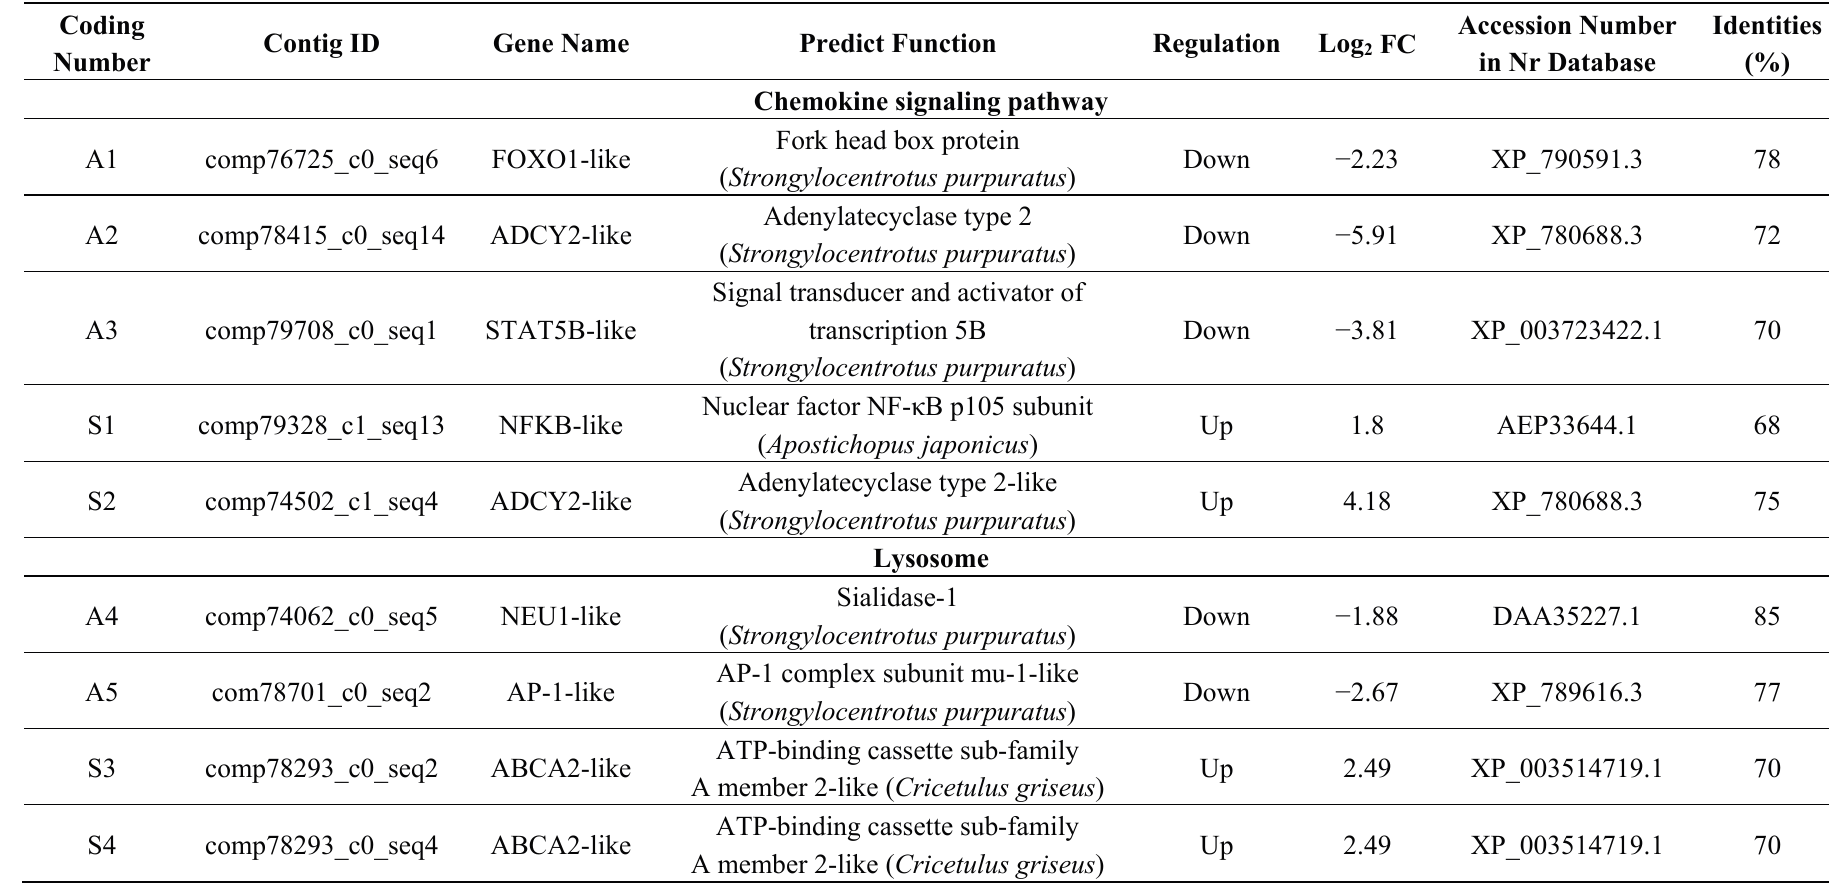
Table 4. A subset of candidate Vibrio splendidus -resistant and susceptibility genes that are involved in the immune signaling pathway.